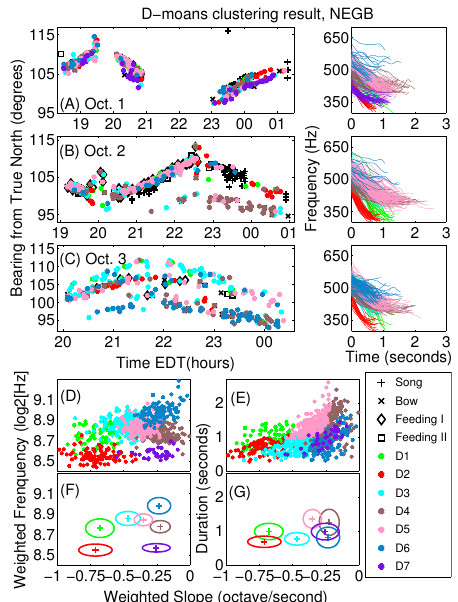
Figure A1. Clustering of NEGB D-moans from 1–3 October identified 7 distinct sub-types. ( A – C ) Bearing-time trajectories of humpback vocalizations with D-moans color-coded based on sub-type clustering; Corresponding D-moan pitch-tracks are indicated for each day; ( D ) The ensemble of amplitude weighted slope and frequency features; ( E ) The ensemble of amplitude weighted slope and duration features; ( F ) The mean and one standard deviation of amplitude weighted slope and frequency features; ( G ) The mean and one standard deviation of amplitude weighted slope and duration features for each D-moan sub-type cluster. The D-moan sub-type D7 is present on 1 October, but absent on 2 and 3 October.